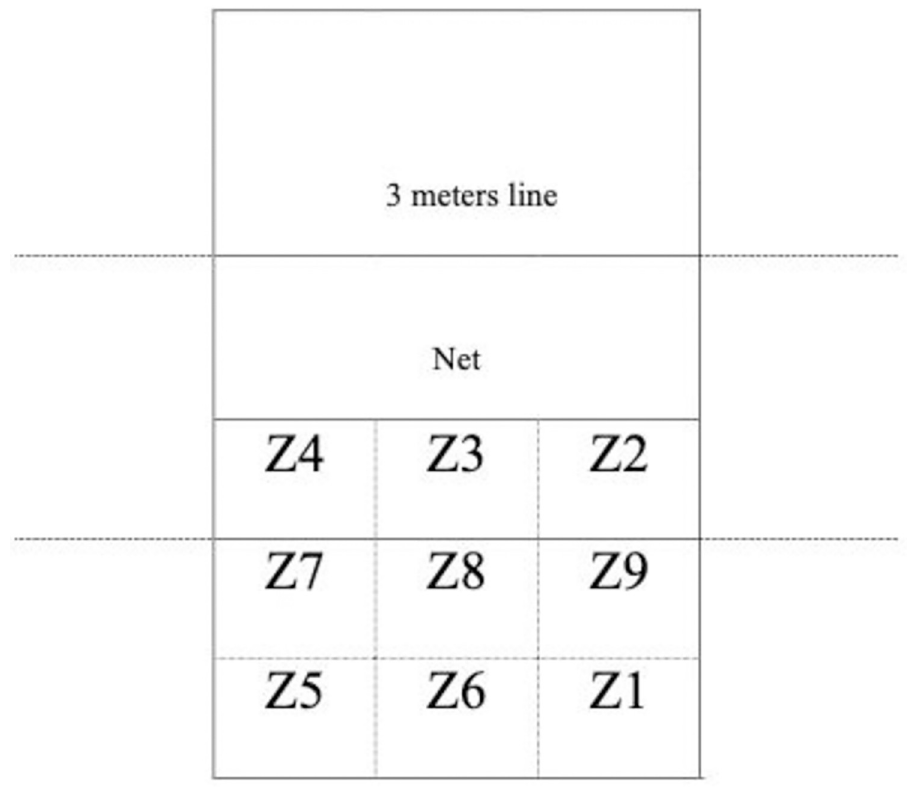
Fig 1. Reception